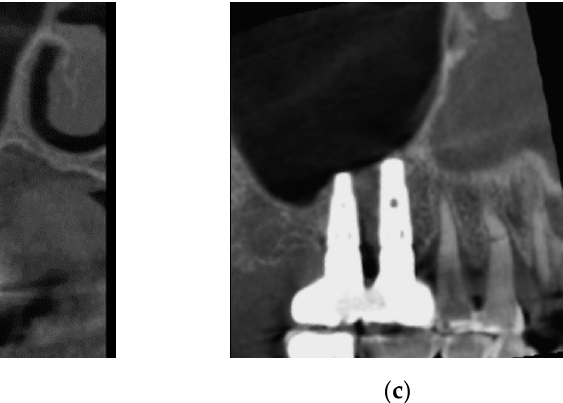
Figure 5. Patient #1. CBCT performed after 6 months of functional loading of the implants, showing graft maturation and the formation of a new cortical layer at the top of the implants. No radiopacity or residual graft disseminated into the sinus cavity were observable in cross-section ( a ) and ( b ) or in Panorex ( c ) images.